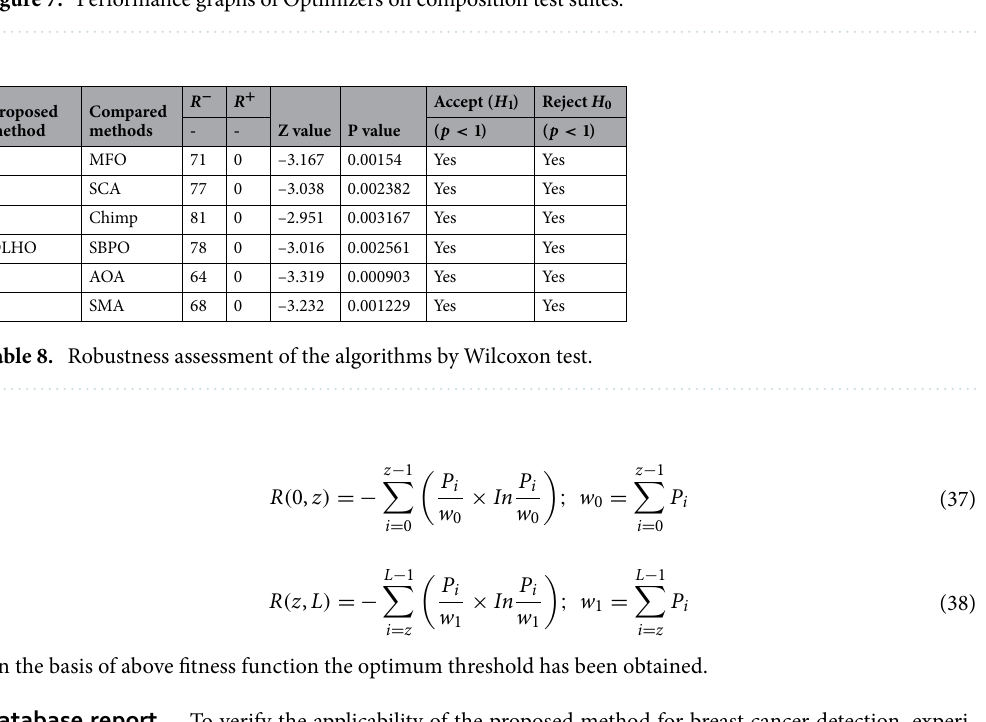
Figure 7. Performance graphs of Optimizers on composition test suites.